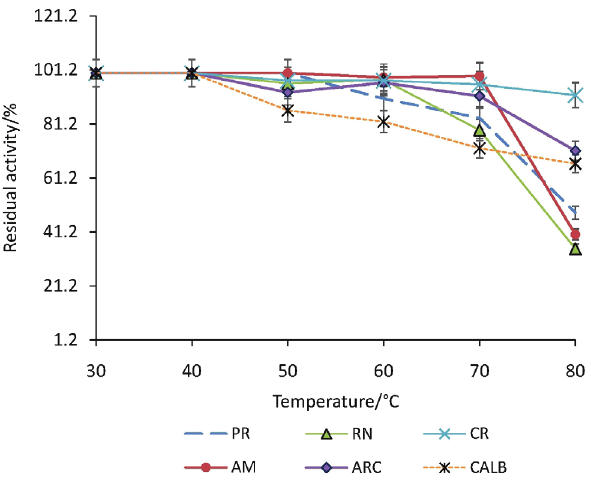
Fig. 4c – Stability of lipases at different temperatures in phosphate buffer compared to the initial activity after incuba- tion for 12 hours